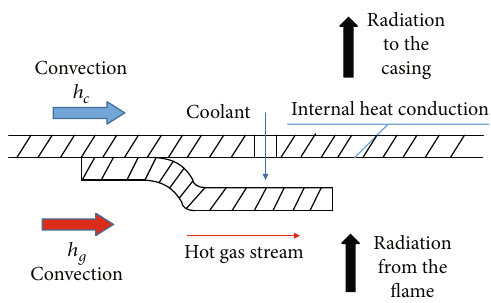
Figure 1: Heat transfer model of combustor wall.